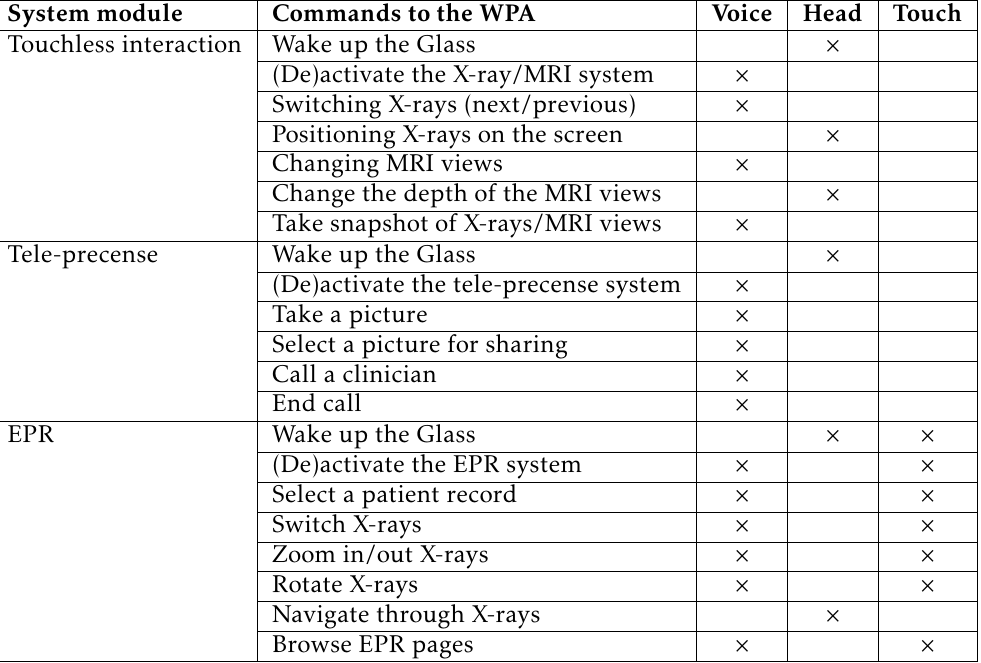
Table 1. Input modalities for each module of the Wearable Personal